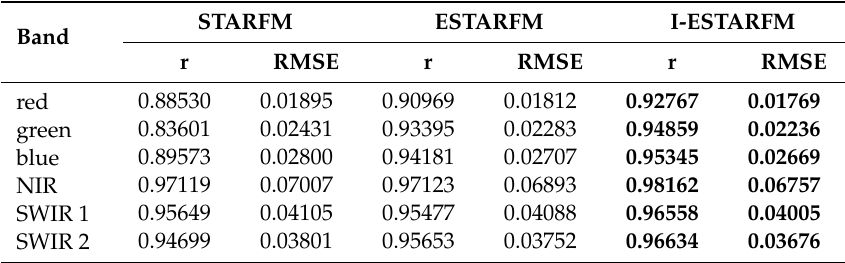
Table 3. Accuracy assessment results of study area 1.